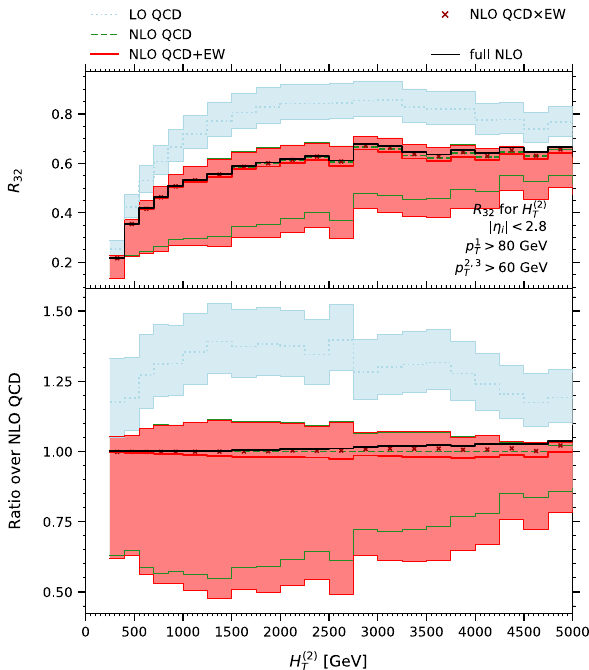
Fig. 8 The R 32 observable differential in H ( 2 ) tionsatLOandNLOQCD,NLOQCD + EW,NLOQCD × EWandfull NLO in the Standard Model. Lower panel: Related relative corrections w.r.t. the central NLO QCD